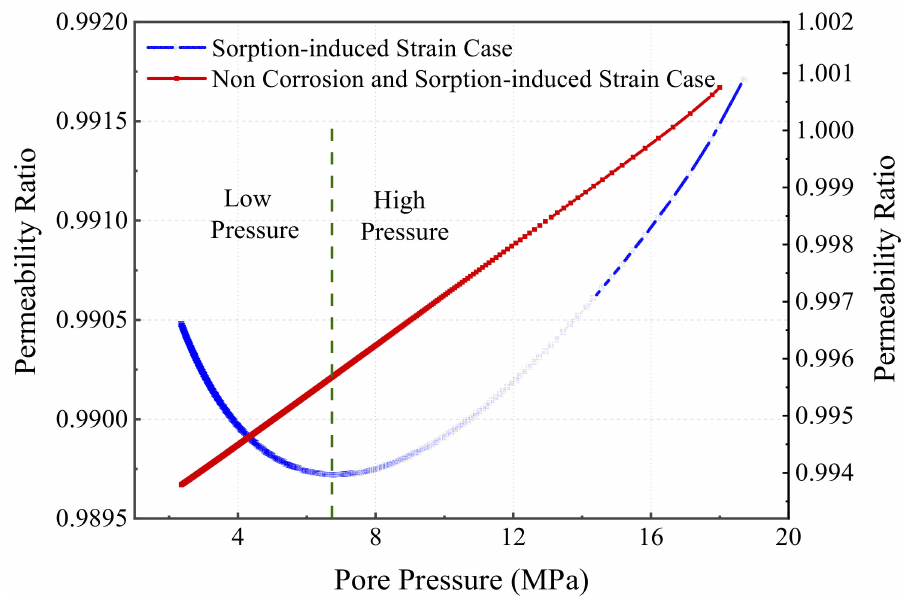
Figure 4. Permeability change curve of CO 2 -bearing oil shale considering sorption-induced strain case.